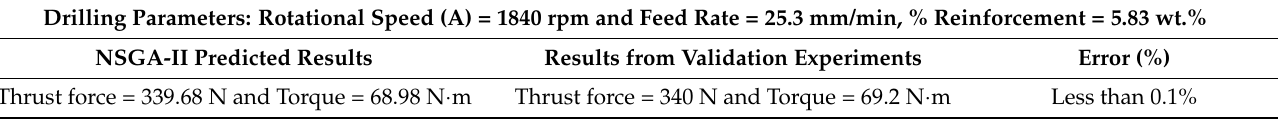
Table 5. Comparison of NSGA-II predicted results and validation